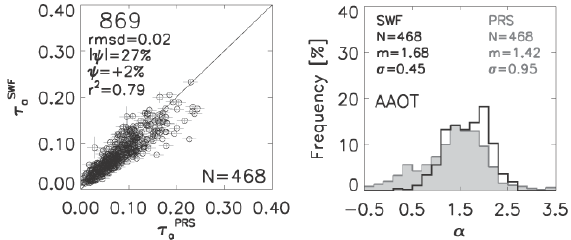
Fig. 14. Same as in Fig. 13 but for MODIS-A with α determined from τ a at 748 and